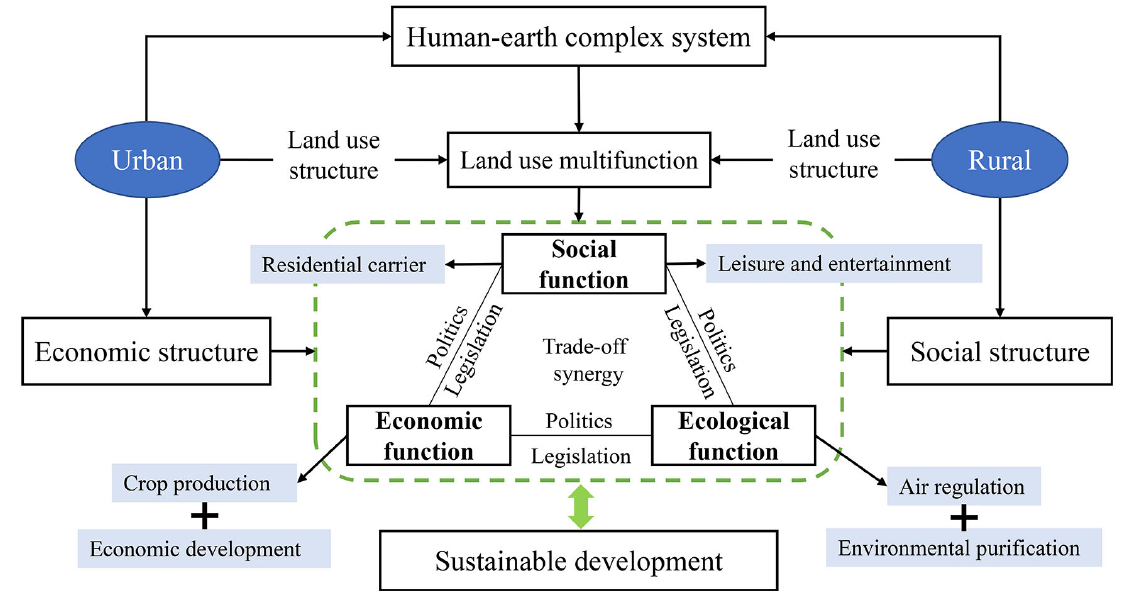
Figure 2. The conceptual framework of LUFs in the urban fringe.